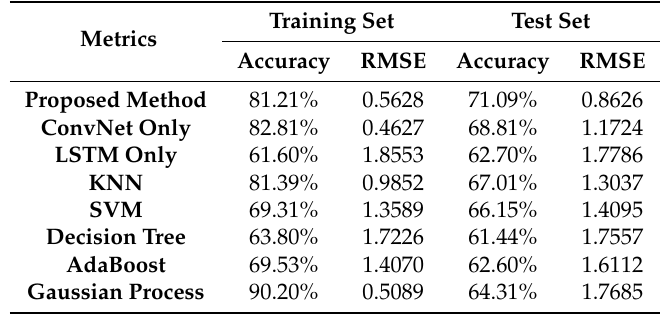
Table 2. Test results for using 8 runs in all 9 tracks as training set, and the other 2 runs in all 9 tracks as test set. Results of the proposed method (i.e., ConvNet + LSTM)) are compared with those of other machine learning methods using accuracy and RMSE as metrics respectively; higher accuracy and lower RMSE are